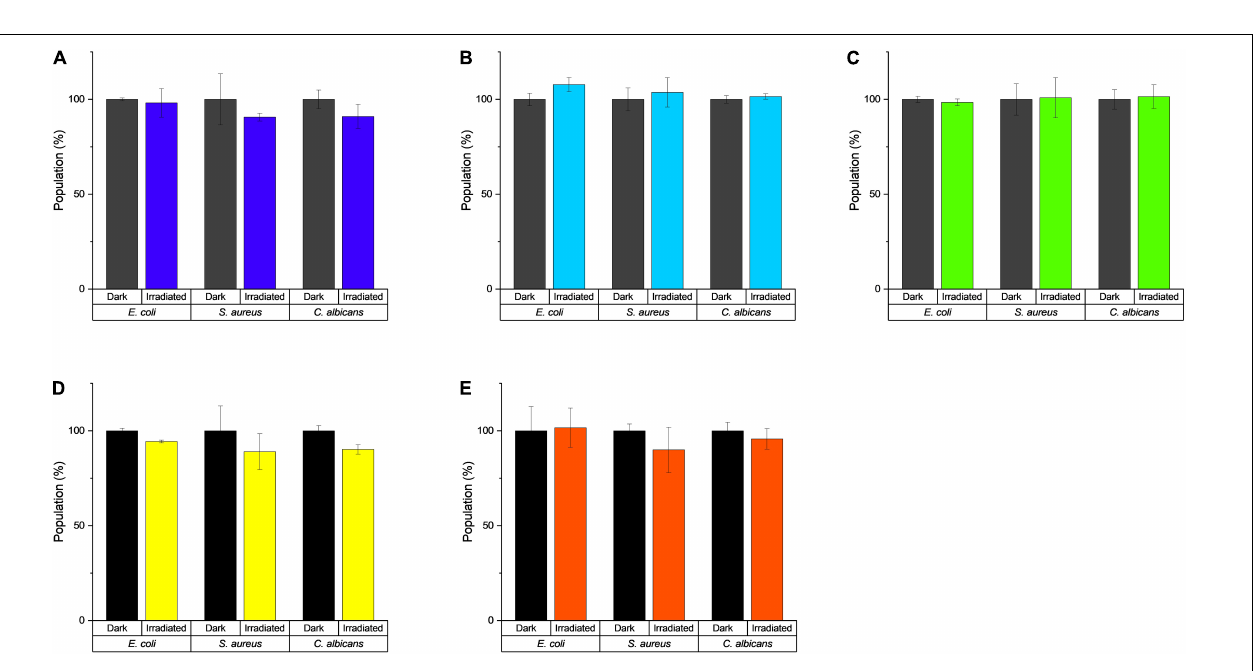
FIGURE 4 | Effect of light irradiation on the growth of E. coli , S. aureus , and C. albicans . (A) λ irr = 428 nm, H = 30 J/cm 2 , (B) λ irr = 478 nm, H = 30 J/cm 2 , (C)